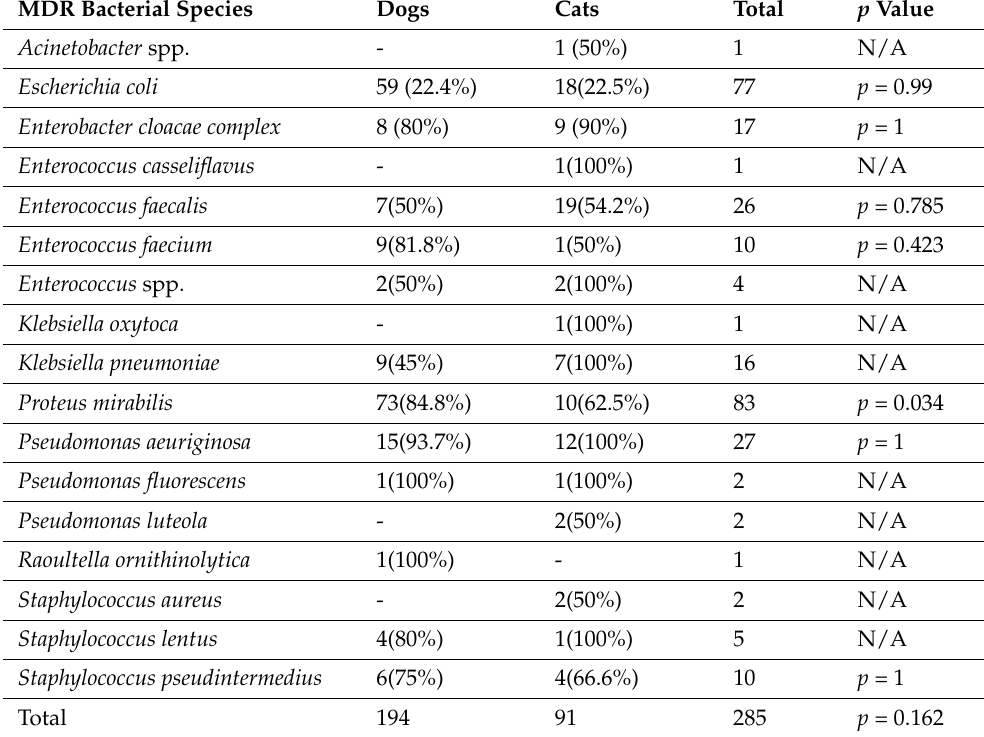
Table 2. Numbers of multidrug resistance bacteria in different strains isolated from urine samples of dogs and cats in Central Italy during January to December 2020. The percentage values are reported in brackets.